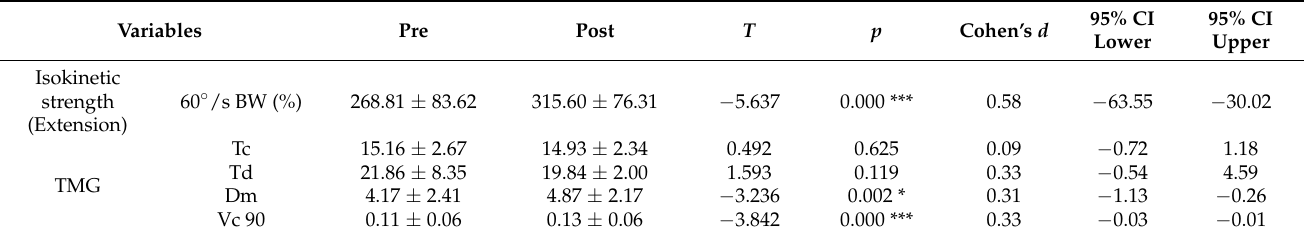
Table 3. Results of TMG and isokinetic strength variables of the